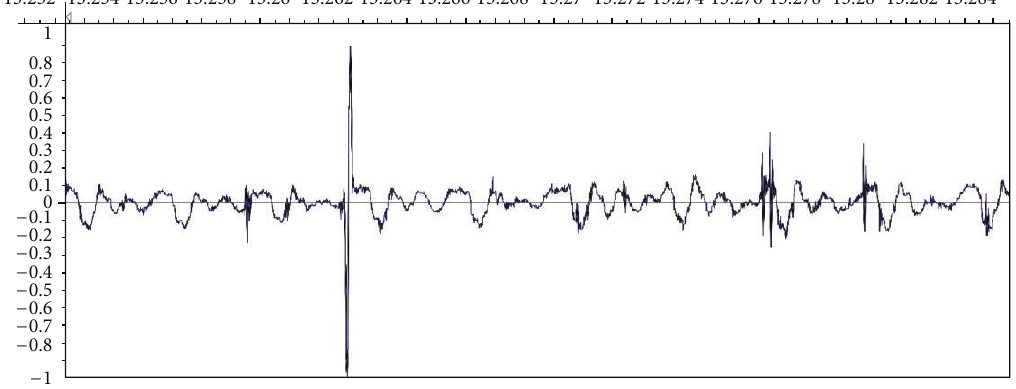
Figure 2: The figure shows an example of impulsive noise (click) in the waveform of an audio signal extracted from a 78 rpm shellac disc. It is clearly visible at second 13.263. Such disturbance can be caused by a speck of dust in a disc groove. Time (seconds) is shown on the 𝑥 -axis; amplitude (normalized) is shown on the 𝑦 -axis.